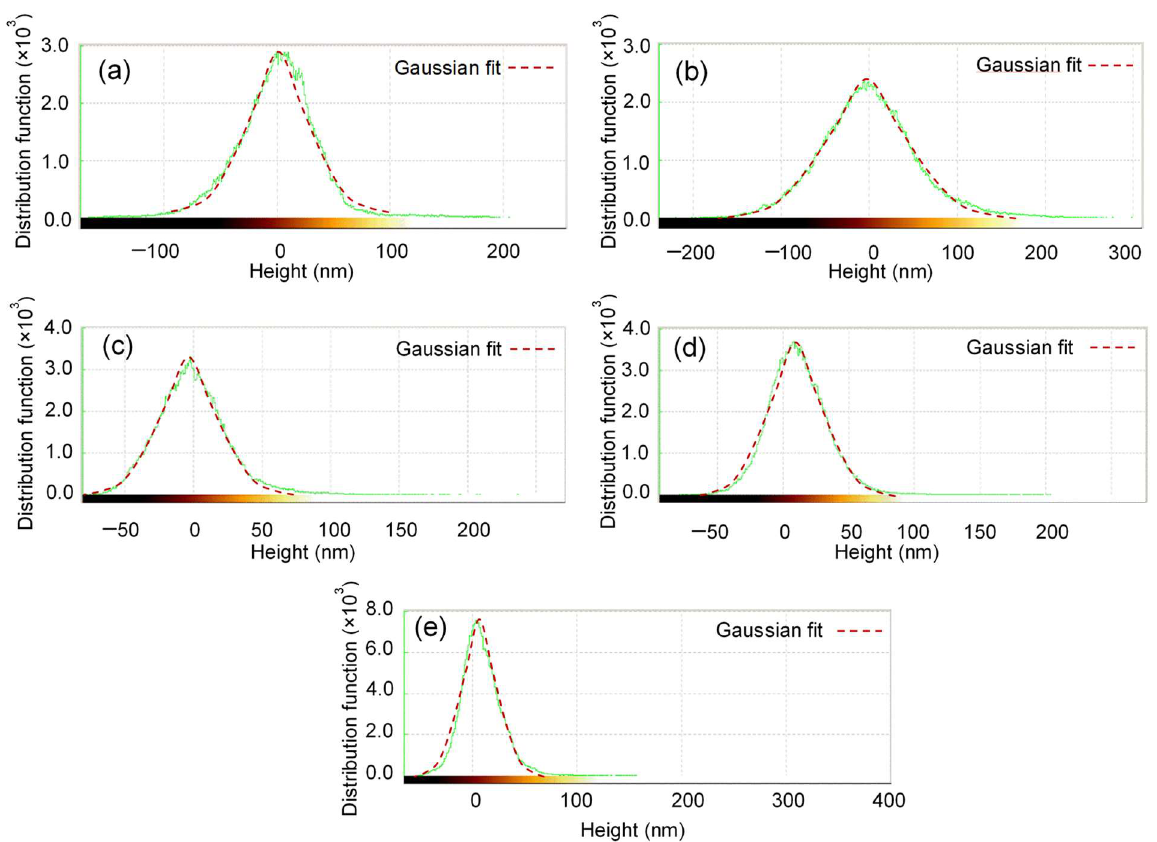
Figure 6. Histogram of the height distribution function in AFM images of ( a ) uncoated nylon, ( b ) Ag–Se-6/nylon, ( c ) Ag–Se-12/nylon, ( d ) Ag–Se-24/nylon, ( e ) Ag–Se-30/nylon samples.